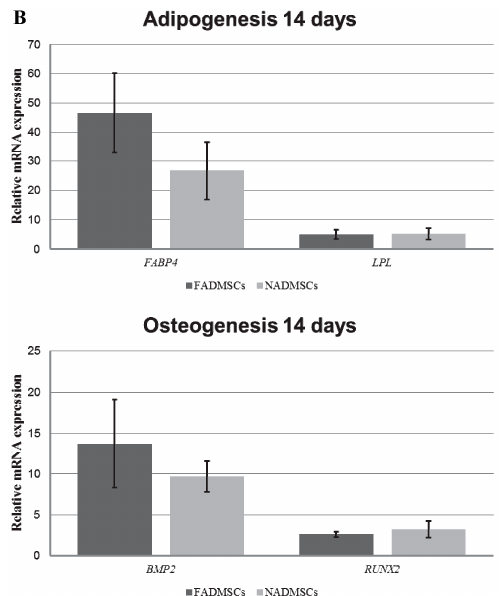
Figure 6. Adipogenic differentiation and osteogenic differentiation of ALF-derived ADMSCs and normal ADMSCs at passage 5. ( A ) The cell morphology transition of adipogenic and osteogenic cells after 14 days under a microscope: The white boxes of the second row indicate the lipid accumulation in adipogenic ADMSCs; The white boxes of the last row indicate the calcium accumulation in osteogenic ADMSCs. The first row and the last row: Scale bars = 200 μ m; the second row: Scale bars = 50 μ m; ( B ) The mRNA expression levels of adipogenic markers and osteogenic markers were significantly increased after 14 days. The relative expression levels in undifferentiated ALF-derived ADMSCs and normal ADMSCs were normalized to 1. The results are representative of three independent experiments. Mean ± SD values are plotted.